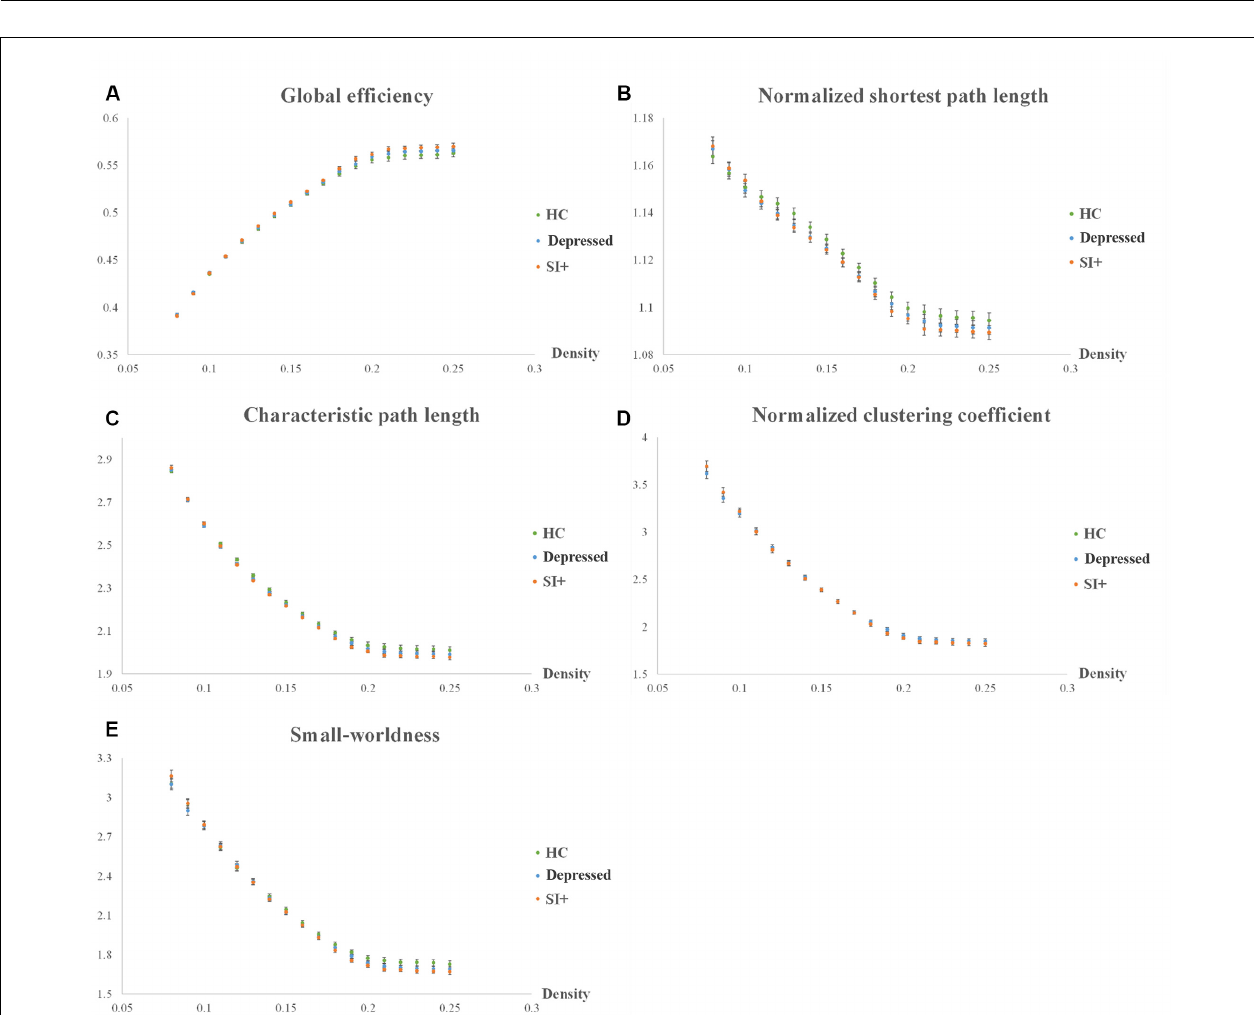
FIGURE 3 | Topological parameters of graph theoretical analysis. Five topological parameters were investigated among the three groups (SI, Depressed, and HC): (A) global efficiency, (B) normalized shortest path length ( λ ), (C) characteristic path length, (D) normalized clustering coefficient ( γ ), and (E) small-worldness index.